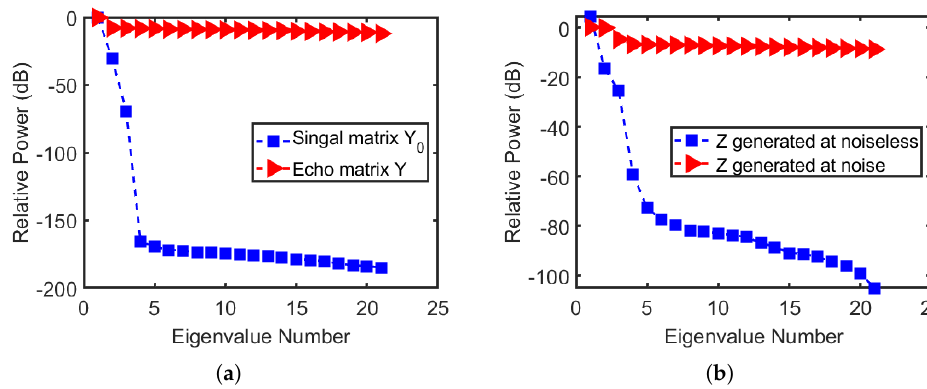
Figure 2. Eigenvalue distribution comparison: ( a ) received echo; ( b ) generated